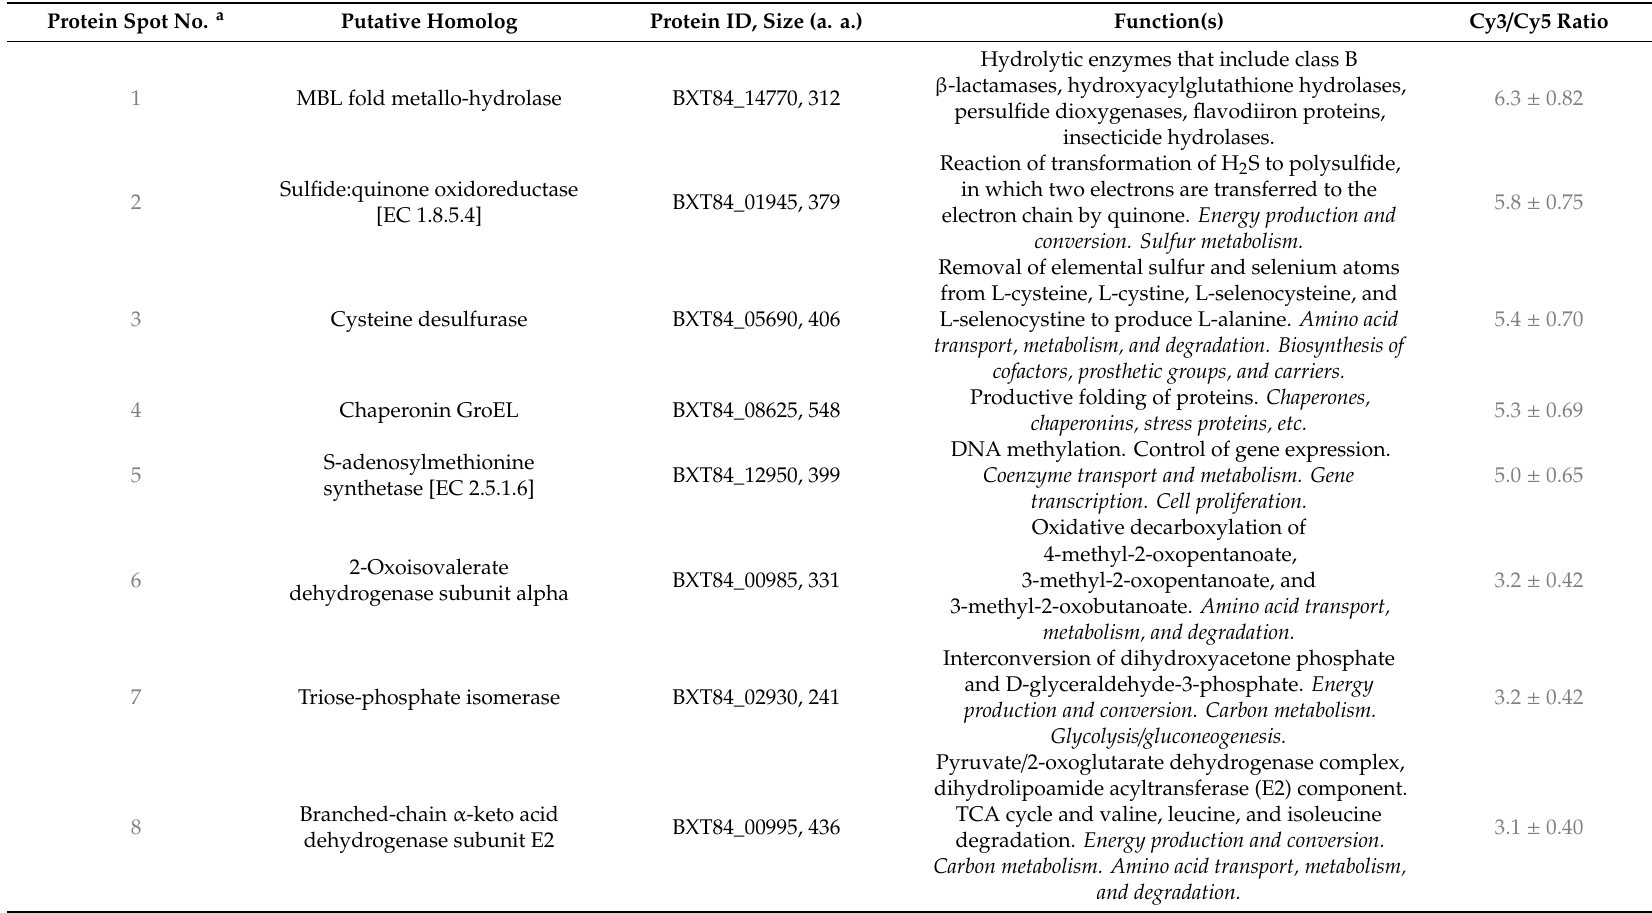
Table 3. Proteome reorganization in the Sb. thermotolerans cells grown under optimal conditions (Cy5, red) and in the presence of the gold-bearing arsenopyrite concentrate (Cy3, green). Protein spot numbers and ratios in green or red indicate up- or downregulation, respectively, in response to the sulfide concentrate. Protein Spot No.